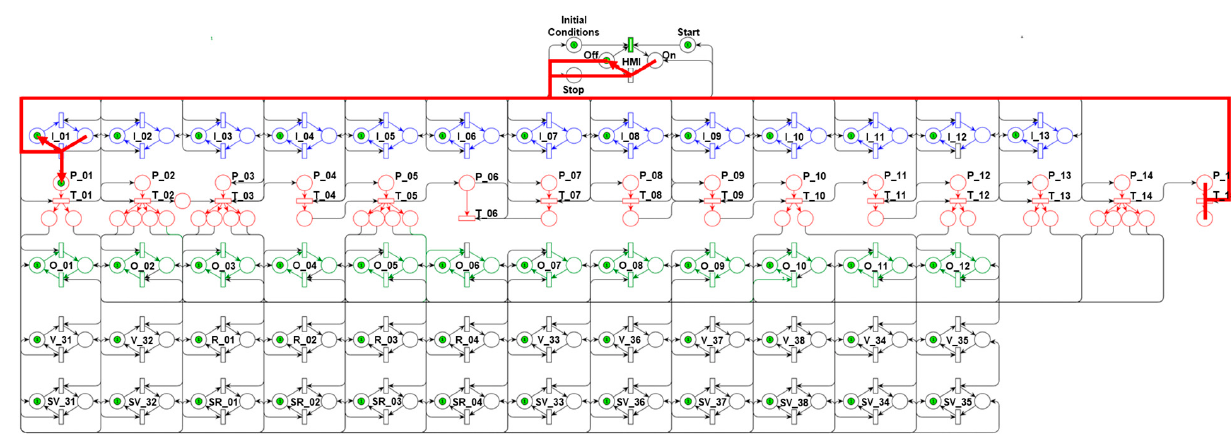
Figure 40. Algorithm’s 15th step—End simulation.